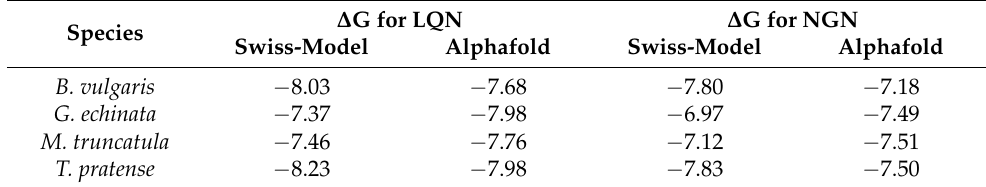
Figure 5. Key amino acids along with Liquiritigenin (docked as a ligand) in selected IFS homology models: ( A ) T. pratense (AAP06953.1), ( B ) G. echinata (BAA76380.1) and ( C ) M. truncatula (QBF58774.1). Key amino acids and LQN structure are shown in the stick model. LQN is shown in red; key amino acids are shown in rainbow colours. Polar interactions are shown in yellow dotted lines, and the distance is shown in Å units. Table 2. Binding energy ( ∆ G) comparison of selected IFS docked with LQN and NGN. ∆ G for LQN ∆ G for NGN Species Swiss-Model